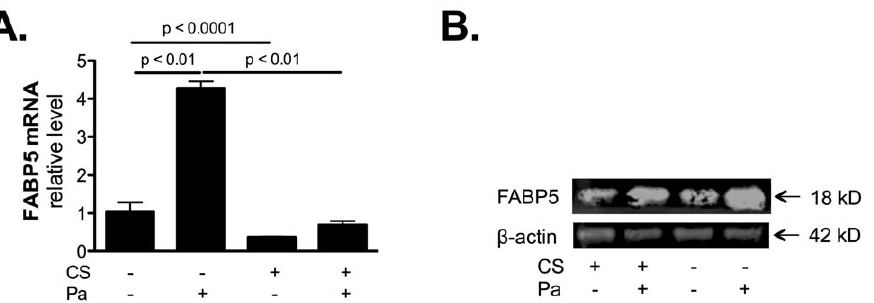
Figure 2. CS exposure prevents bacteria-induced FABP5 expression. A. FABP5 mRNA expression is increased post P. aeruginosa infection, however CS exposure decreases FABP5 mRNA expression and prevents bacteria-induced FABP5 mRNA expression. B. Representative Western blot detection of FABP5 and b -actin proteins shows that FABP5 protein levels increased post Pa infection but CS exposure decreases Pa-induced FABP5 protein levels. Data are representative of 3 independent experiments and are expressed as mean 6 SEM.